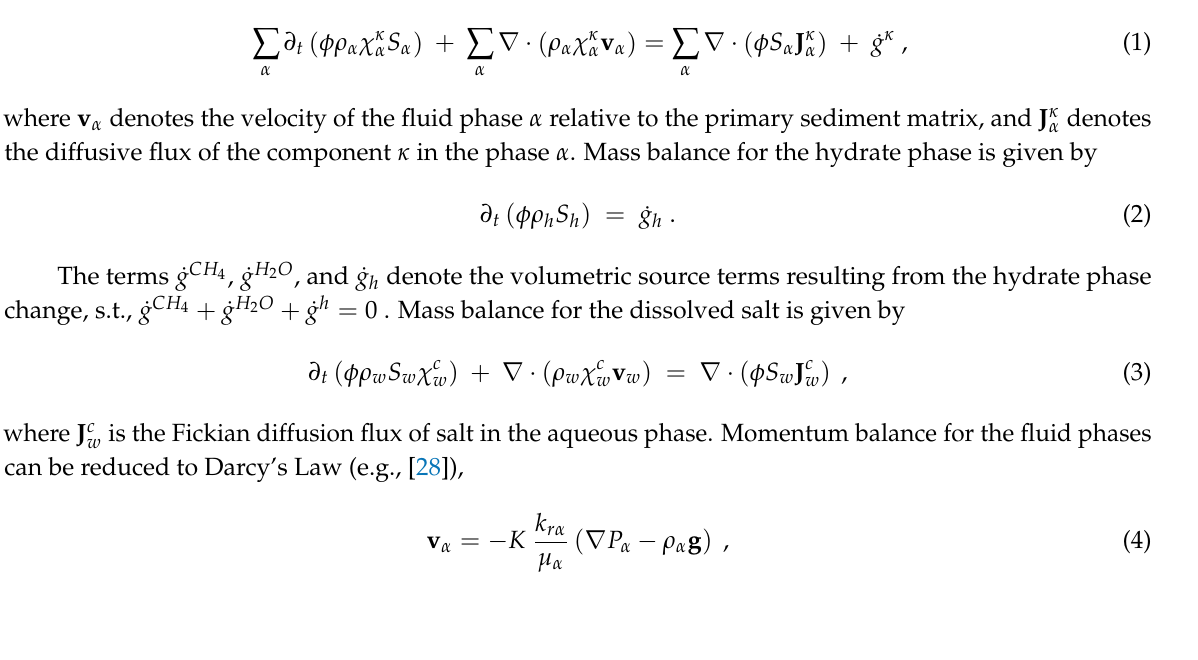
Figure 1. Representation of the phases and components in a representative elementary volume (REV). For any pore-filling phase β = g , w , h , phase saturation is defined as S β : = − V h = ( 1 − S ) φ , , and φ ef f : = V p defined as φ : = V p h V t V t